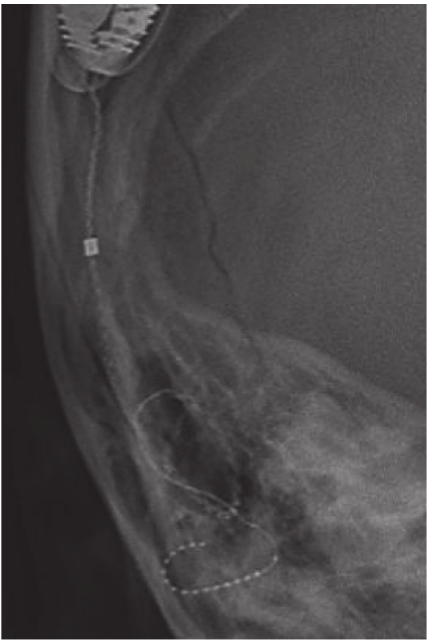
Figure 1: X-ray of the right mastoid (frontal view) showing the implant electrode array possibly coiled up in the region of the external auditory canal.